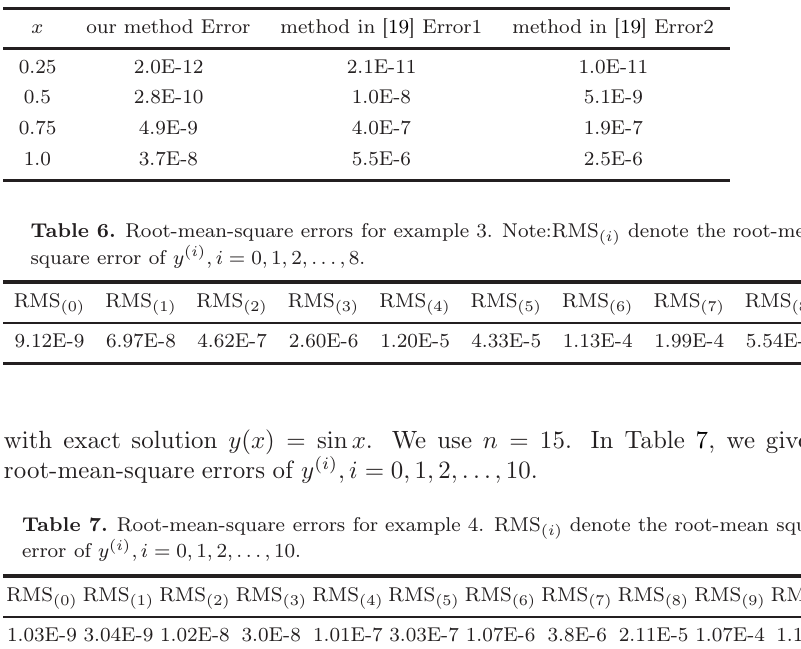
Table 5. Absolute errors for Example 3.